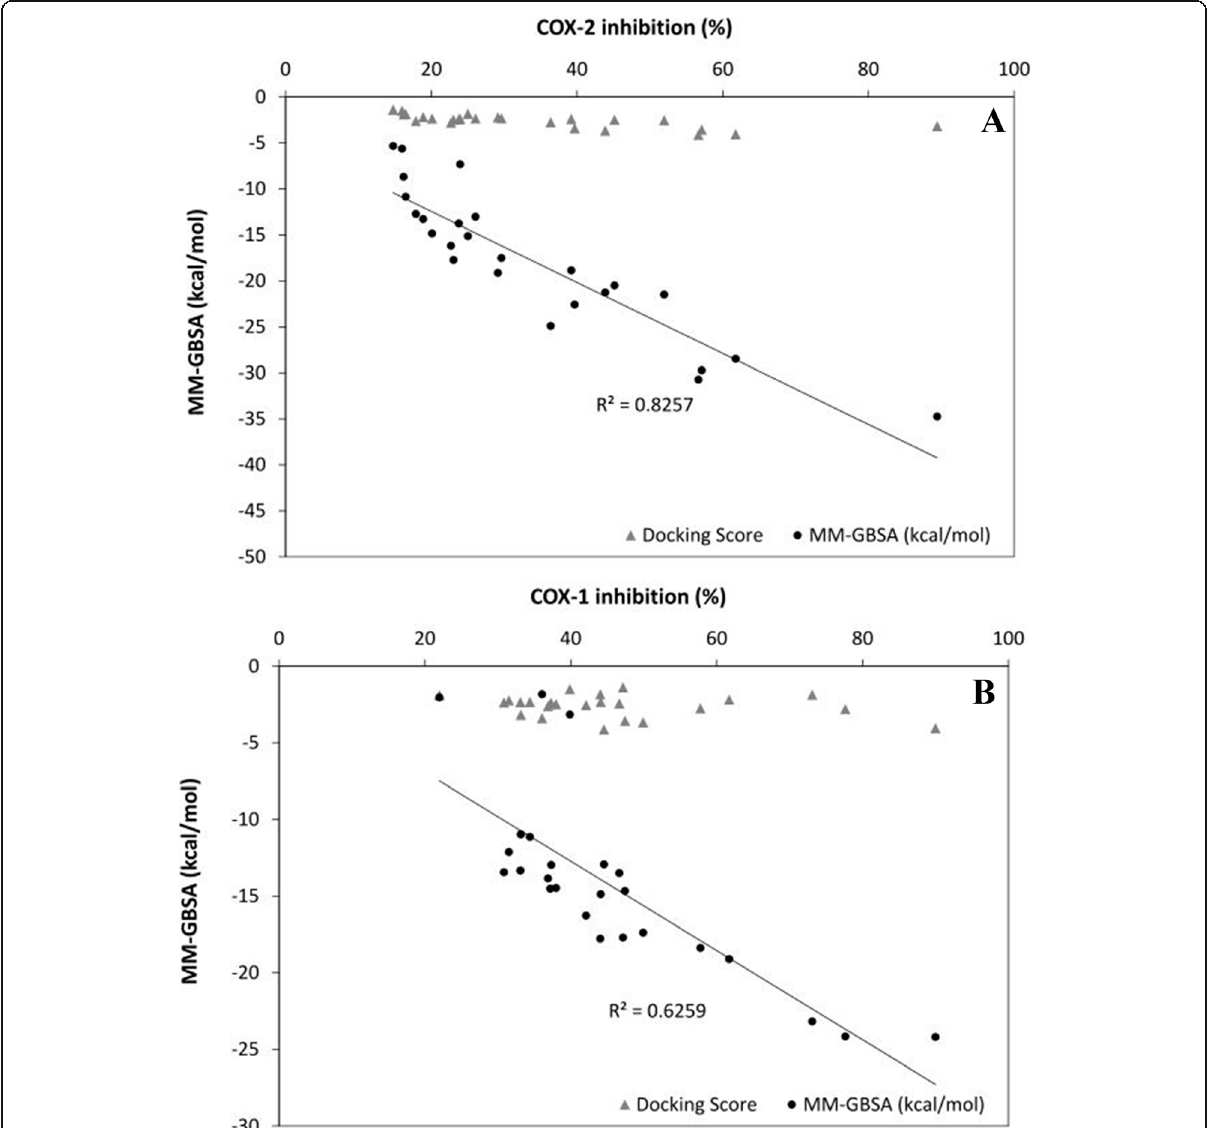
Fig. 5 The calculated binding free energy (MM-GBSA)/Glide docking scores vs. the in vitro inhibitory activity (%) of compounds 37 – 63 against COX-2 ( a ) and COX-1 ( b